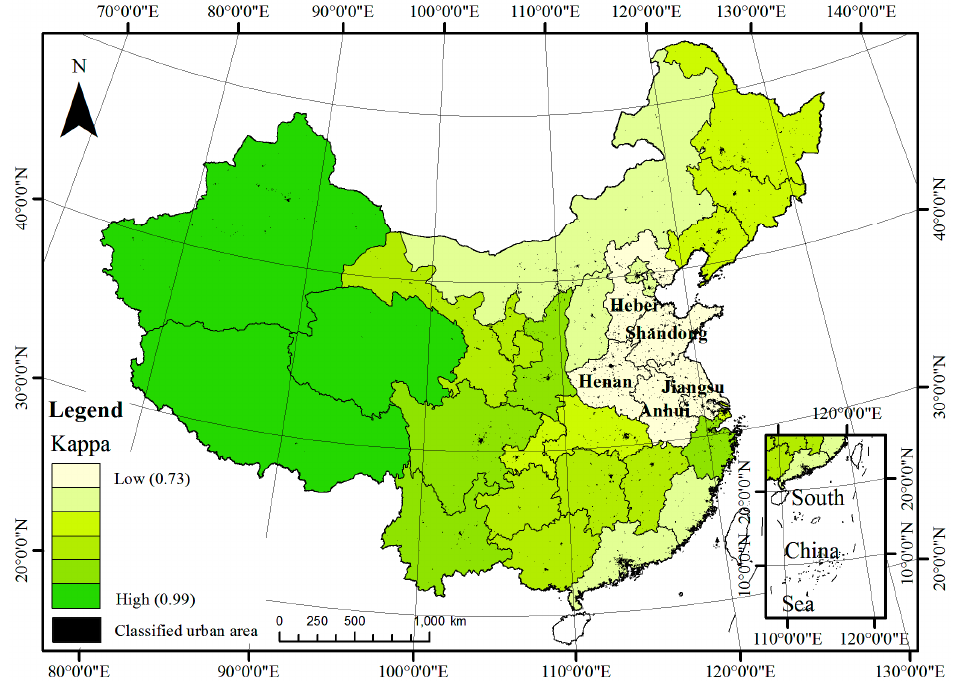
Figure 5. Kappa coefficient distribution at provincial level. The values ranging from 0.73 to 0.99 are divided into six classes by equal intervals.